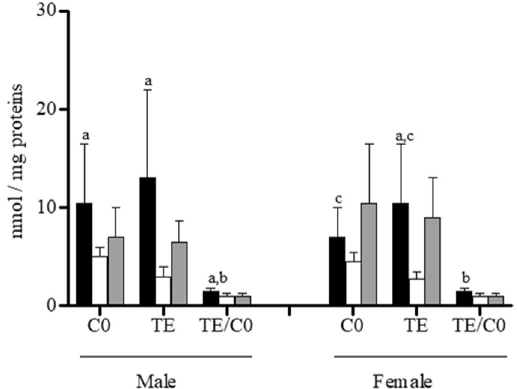
Figure 3. Intra-sex and inter-organ analysis of C0, TE and TE/C0 ratio in male and female livers (black bars), hearts (white bars) and kidneys (grey bars). Data are the medians ± MAD of 15 samples for each tissue and sex. a P < 0.05 between liver and heart; b P < 0.05 between kidney and liver; c P < 0.05 between heart and kidney.